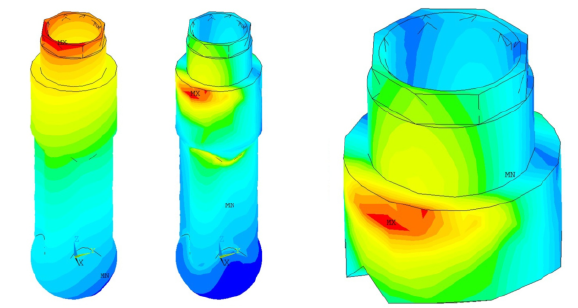
Figure 5. Numerical analysis of the reference im- plant 0001B: displacement – u equivalent von Mises stress – σ σ eqv,max,1 = 73.2 MPa (middle and right).